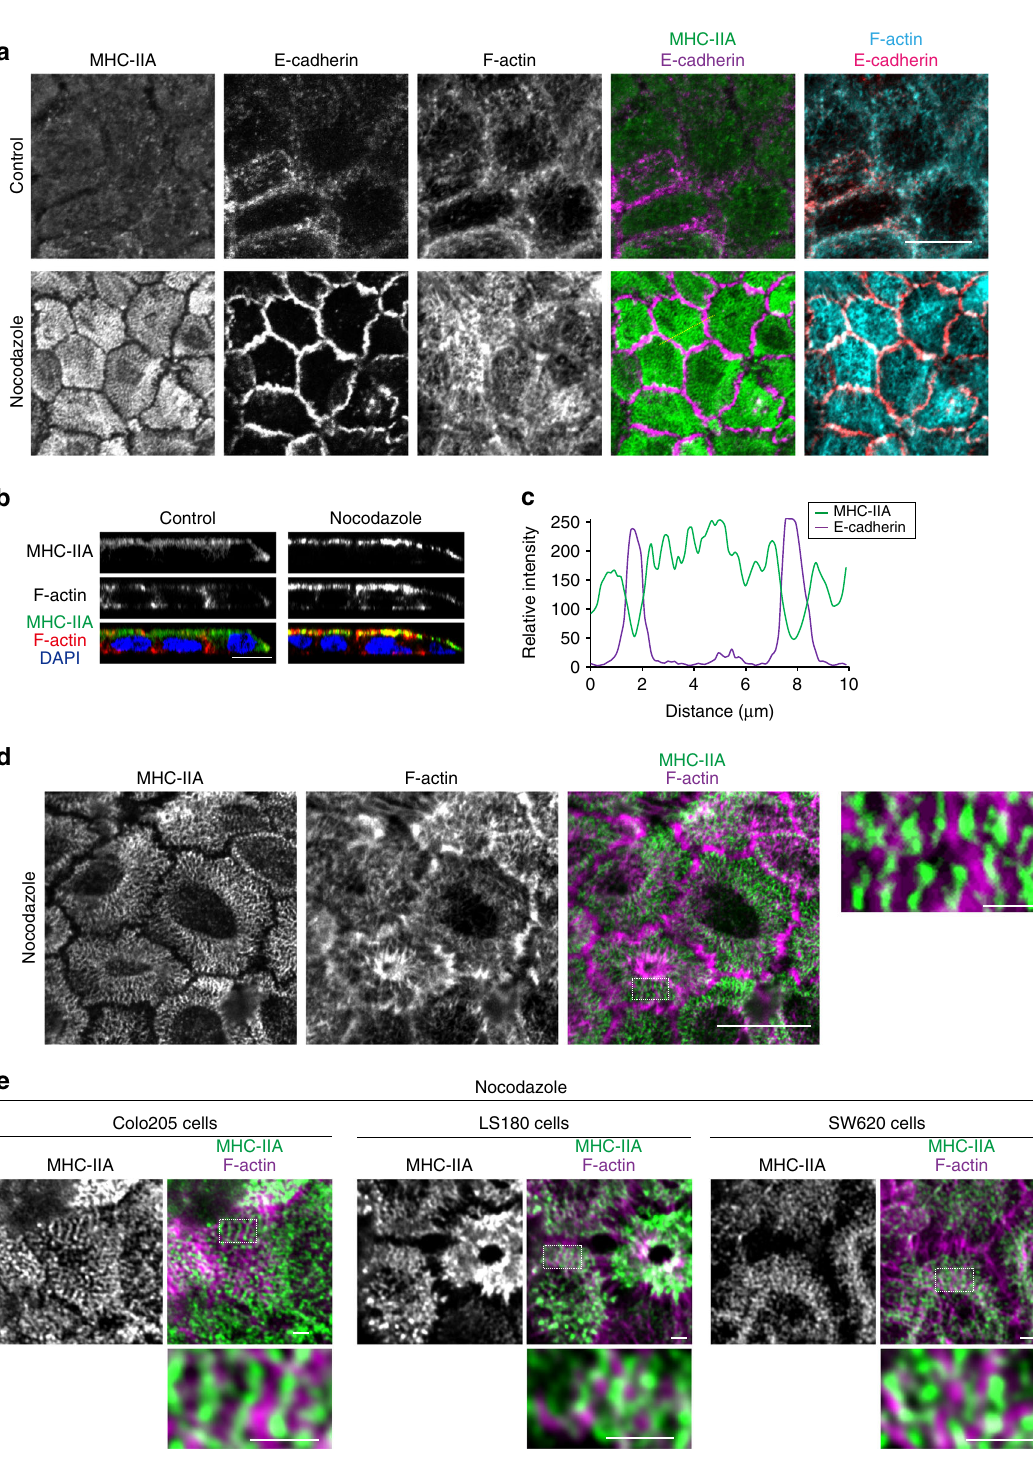
Fig. 4 Reorganization of cortical myosin-IIA by nocodazole treatment. a Immunostaining for MHC-IIA, E-cadherin and F-actin in HT29 cells. b Lateral views of cells immunostained as in a . c Densitometric scans of immunosignals for MHC-IIA and E-cadherin along the yellow line drawn in a . d , e Airyscan images for MHC-IIA and F-actin at the apical plane of HT29 ( d) , and Colo205, LS180 and SW620 ( e) cells, treated with nocodazole. Box regions are enlarged. Scale bars, 10 μ m a , b , d ; 1 μ m d right, e . See also Supplementary Fig. (Supplementary Fig. 2g), but its overall distribution did not particularly change, showing no concentration at cell junctions.